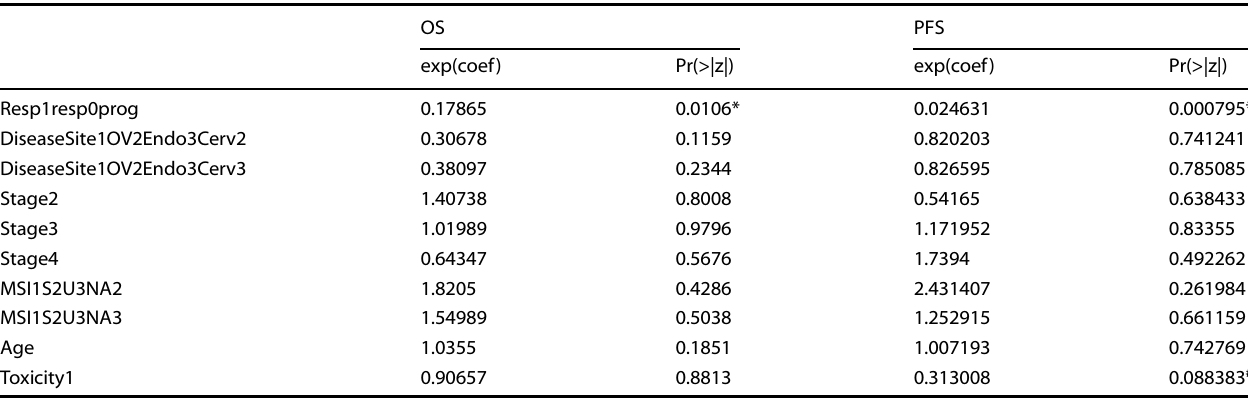
Table 3. Association of clinical features with IO survival outcome, based on Cox proportional hazard